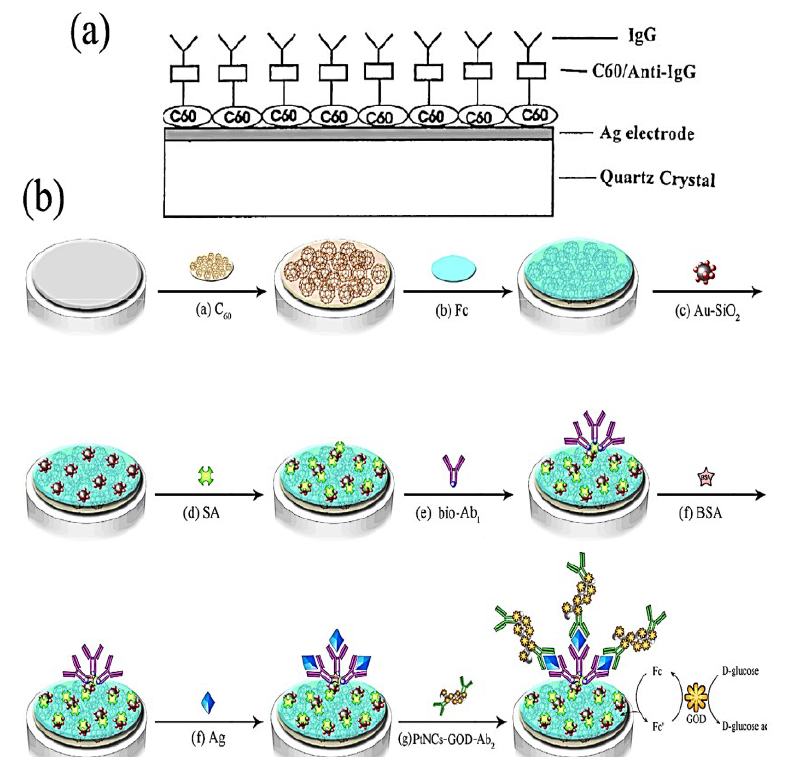
Scheme 3. ( a ) Diagrams of the C 60 -anti-human IgG-coated quartz crystal electrode